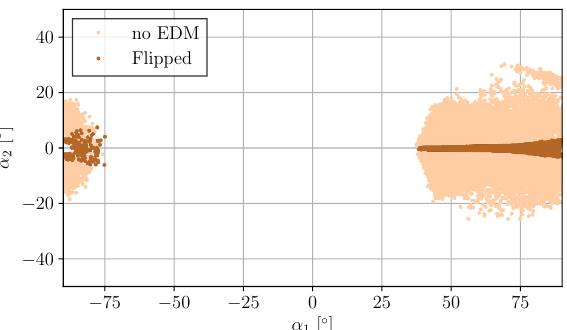
Figure 7 . C2HDM Flipped: mixing angles (cid:11) and sample 2